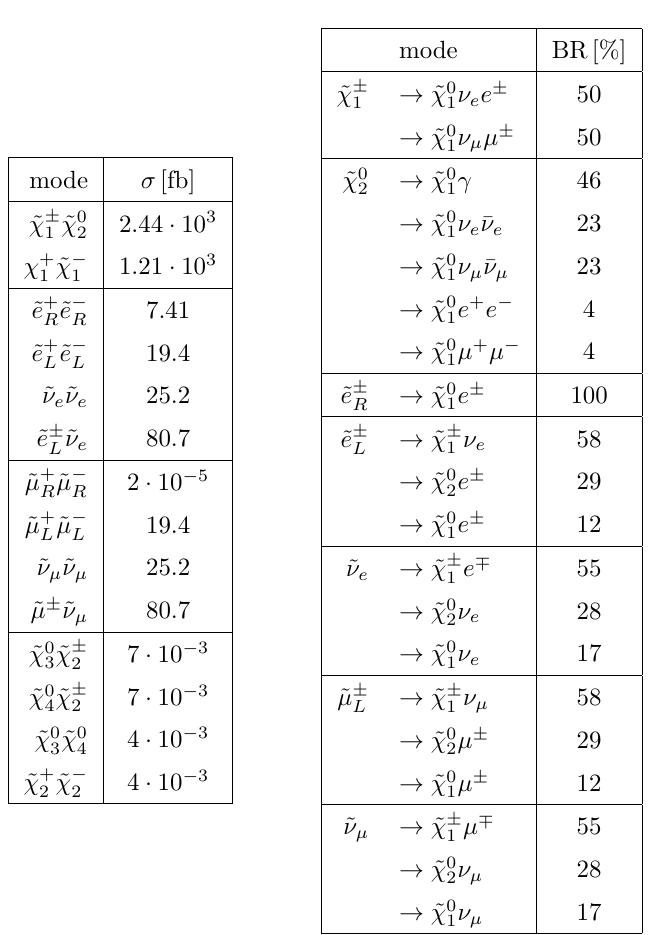
Table 1 . Physical masses in GeV at the benchmark model point BP-1.